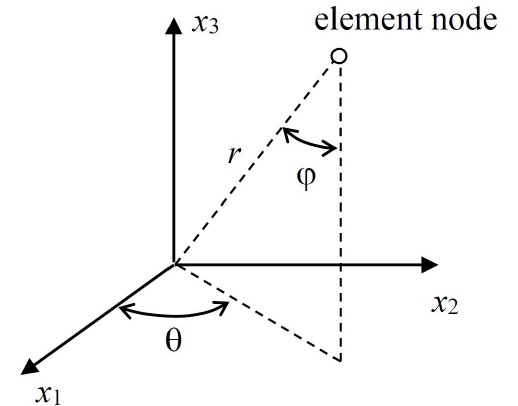
Figure 4. Spherical coordinates used for defining the positions of the element